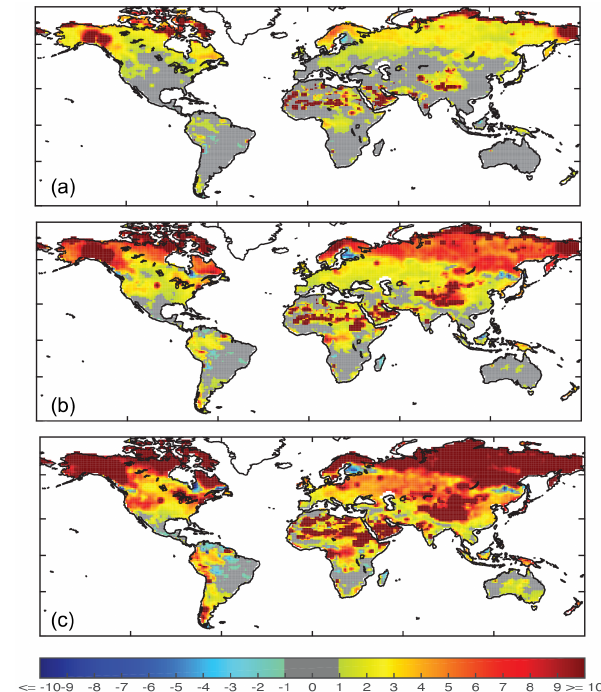
Figure 2. Mean of all models for the annual mean change in LAI over time relative to current (1981–2000), normalized by each model’s current (1981–2000) standard deviation at each grid point, for 2011–2030 (a) , 2041–2060 (b) and 2081–2100 (c) for